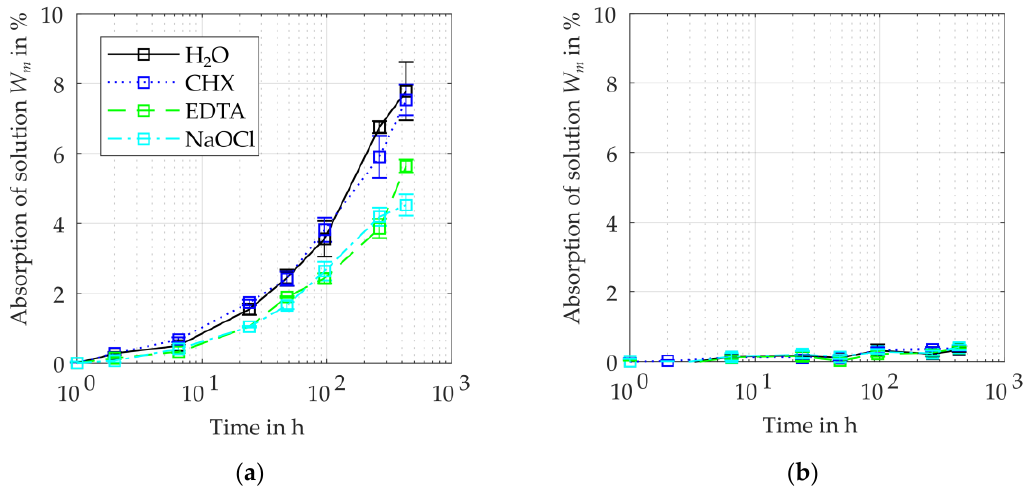
Figure 3. Specific absorption W m of irrigant and water for the investigated thermoplastic polymers: ( a ) PA6 samples; ( b ) PEEK samples.